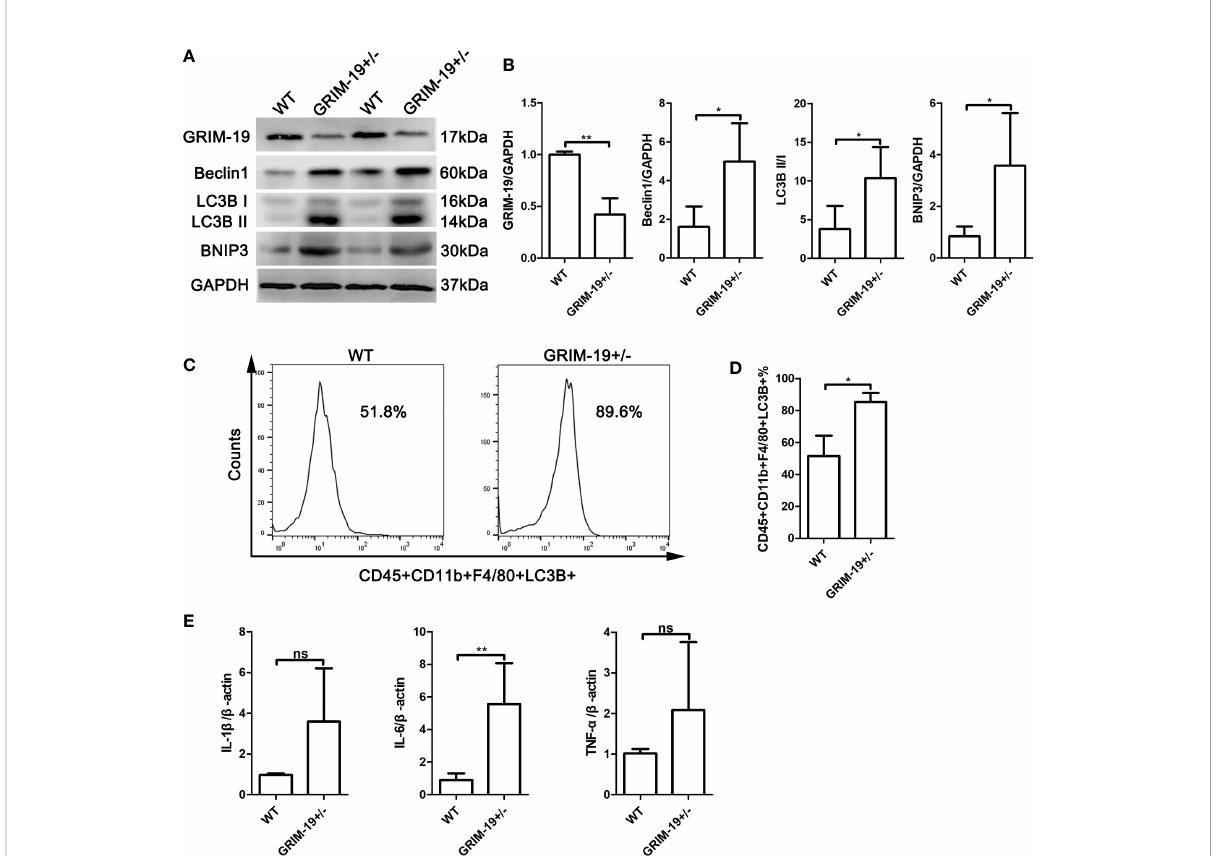
FIGURE 2 Increase in autophagy and in fl ammatory factors in uterine mononuclear cells of GRIM-19 +/- mice. (A) The expression of GRIM-19, Beclin1, LC3B II/I and BNIP3 in uterine mononuclear cells of GRIM-19 +/- mice and WT mice was examined through western blot analysis (4 mice per group). GAPDH served as a loading control. Three independent experiments were carried out. (B) Quanti fi cation of GRIM-19, Beclin1, LC3B II/I and BNIP3 expression through relative densities. (C) Representative images of fl ow cytometry to determine LC3B expression in uterine macrophages (CD45+CD11b+F4/80+LC3B+) of GRIM-19 +/- mice and WT mice (4 mice per group). Three independent experiments were carried out. (D) Percentages of CD45+CD11b+F4/80+LC3B+ cells were identi fi ed. (E) The mRNA levels of the proin fl ammatory cytokines IL1B, IL6 and TNFa in uterine mononuclear cells of GRIM-19 +/- mice and WT mice were detected by quantitative real-time PCR (4 mice per group). Control (WT) mice used in the study were littermates of GRIM-19 +/- mice. Three independent experiments were carried out. Data are shown as the mean ± SD. ** p < 0.01, * p < 0.05, ns, not signi fi